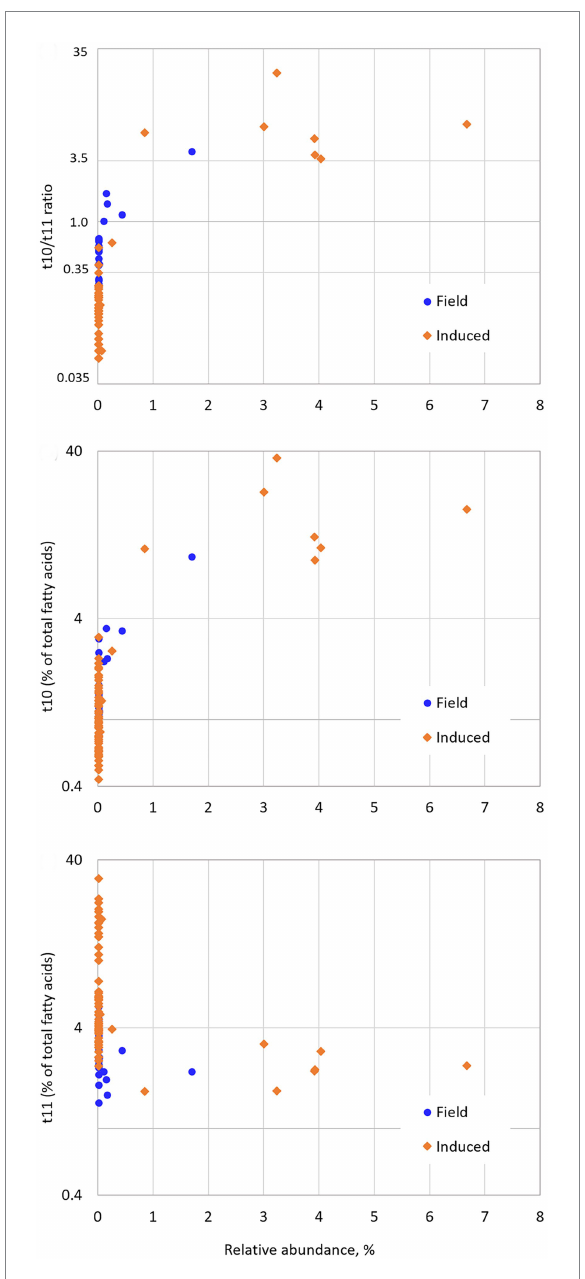
FIGURE. 4 Scatterplots of the relationship between rumen trans -10/ trans -11 ratio, trans -10 an trans -11 fatty acids percentages and GBM- transformed relative abundance of